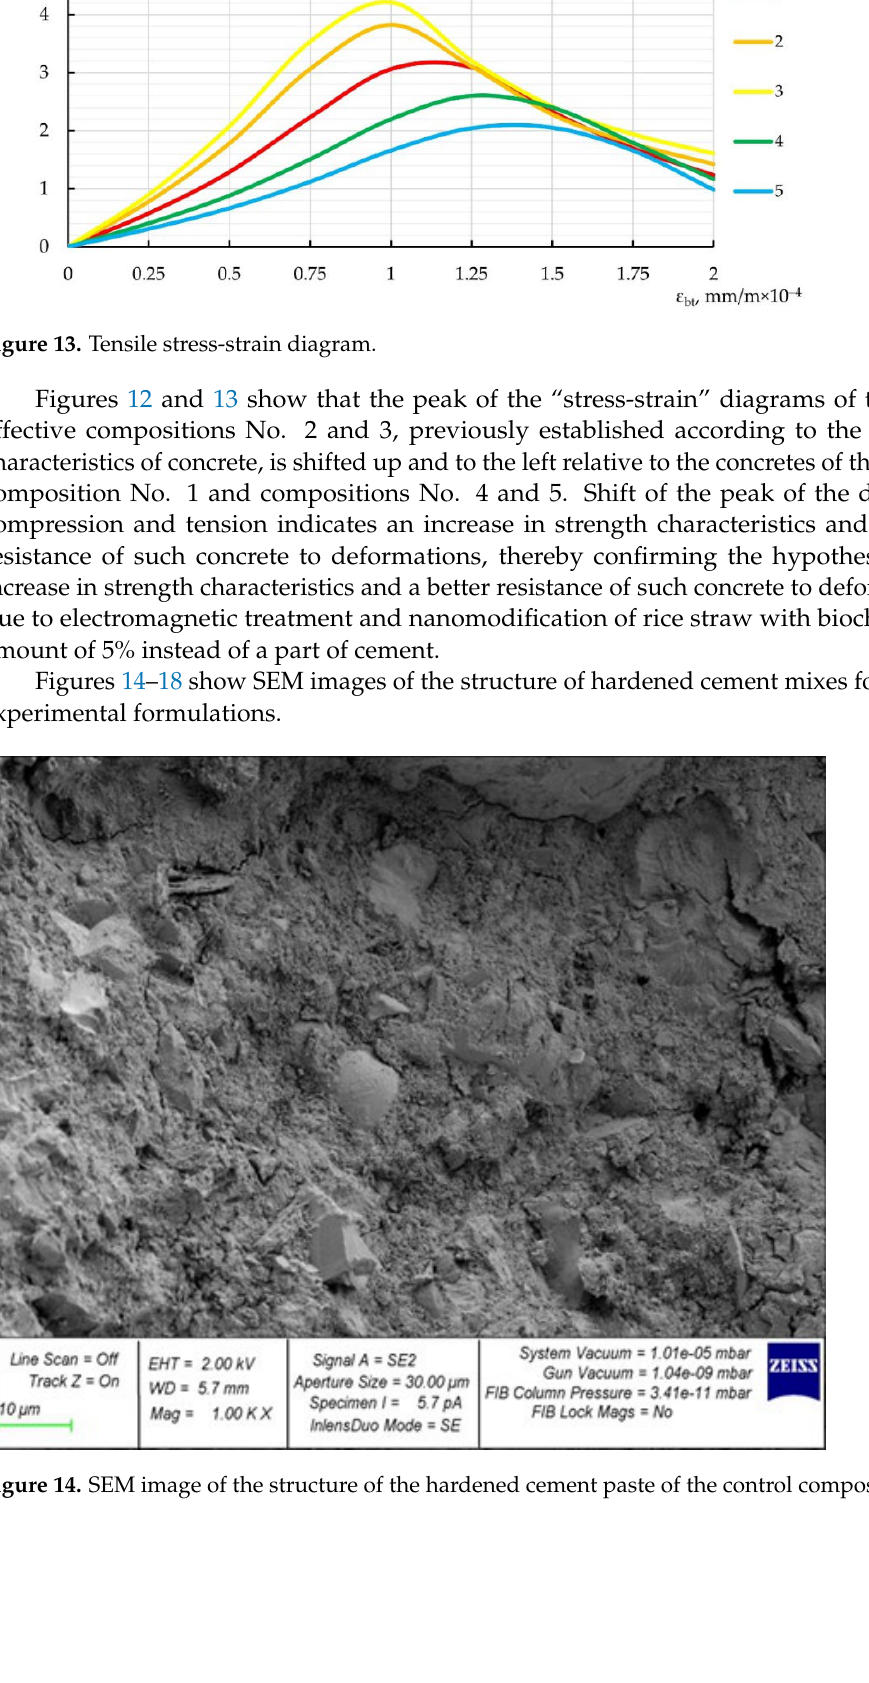
Figure 15. SEM image of the structure of a hardened cement paste subjected to electromagnetic processing.